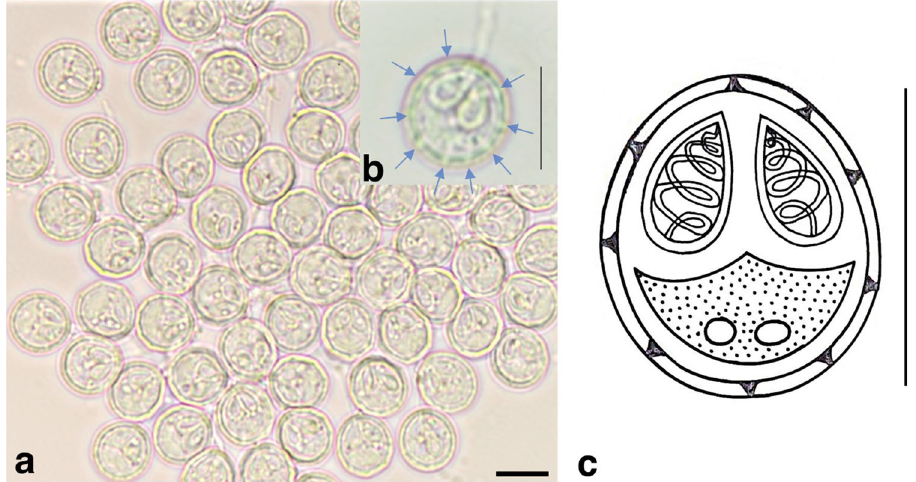
Figure 2. Myxobolus pupkoi n. sp. parasite of the gill arch of Chelon labrosus . ( a , b ) Photomicrographs of mature myxospores (frontal view). Note: arrows indicating sutural folds over the myxospore body. ( c ) Schematic drawing of a myxospore. Scale bars: 5